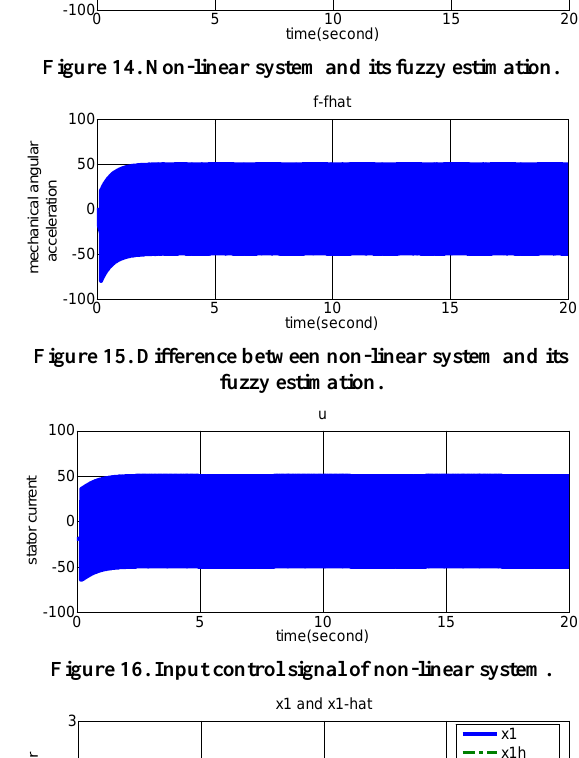
Figure 17. First state and its estimation.